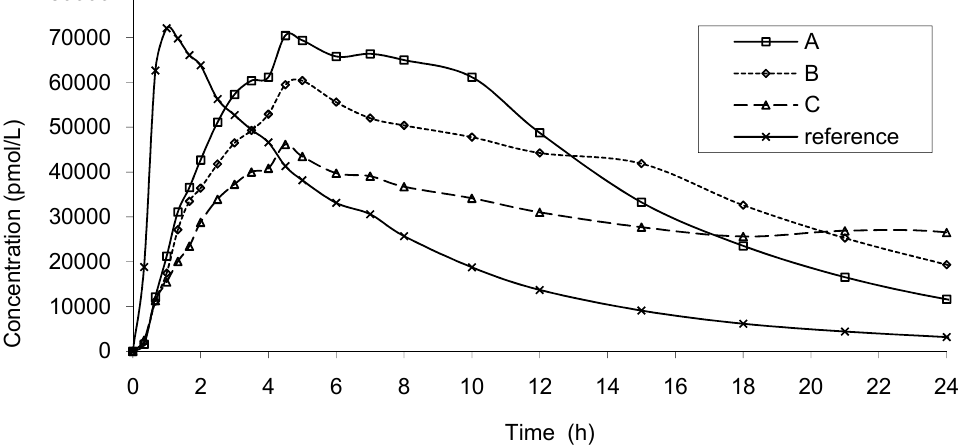
Figure 3. Plasma concentration up to 24 hours post dose of the three test formulations ( A , B and C : test tablet formulations, dose = 20 mg) and of the reference tablet (IR, dose = 10